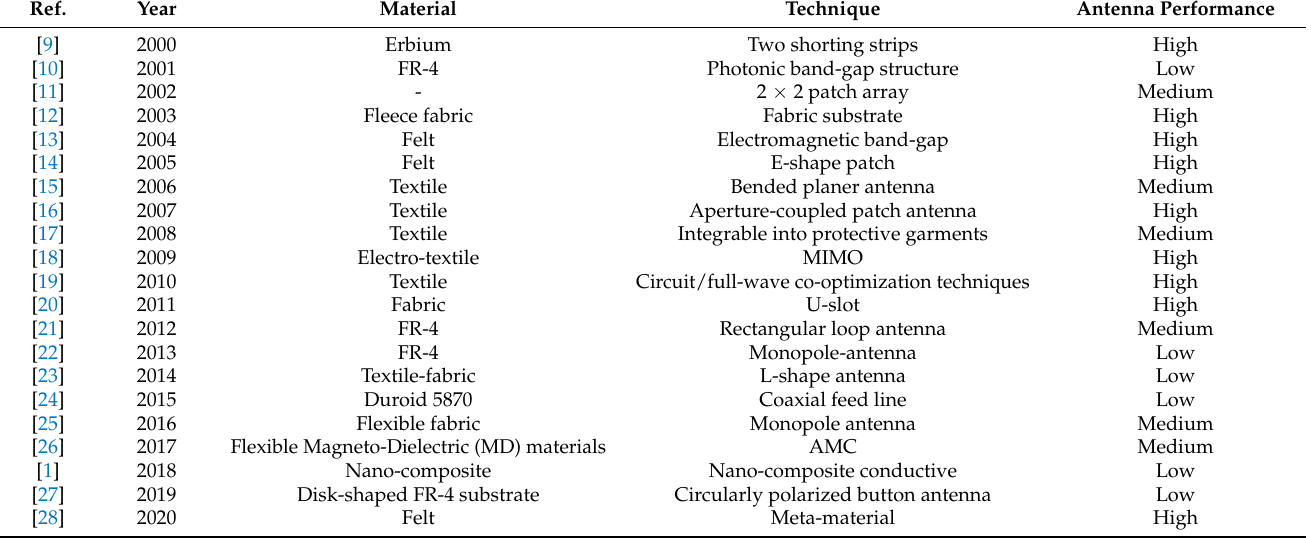
Table 3. Cloth Antenna History and Its